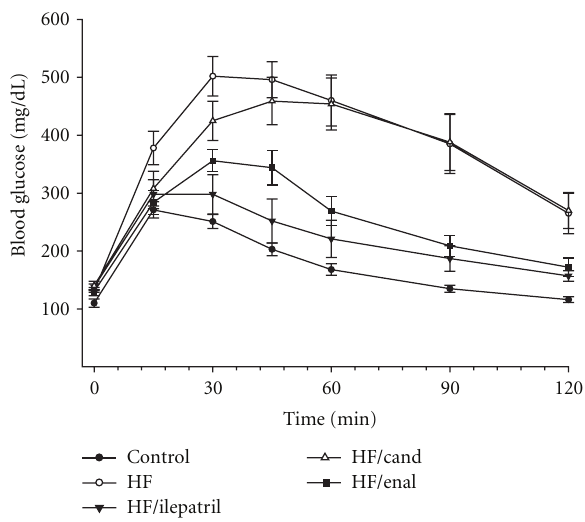
Figure 4: Plasma glucose concentration curve during intraperi- toneal glucose tolerance test (IPGTT) for NEP − / − mice fed a normal or high-fat-containing diet for 24 weeks and the high-fat diet with or without ilepatril, candoxatril, or enalapril for the last 12 weeks (intervention protocol). Data are the mean ± SEM in mM. Fasting basal blood glucose levels were 110 ± 7, 131 ± 5, 138 ± 5, 140 ± 8, and 130 ± 7mg/dL for control, high fat, high fat + ilepatril, high fat + candoxatril, and high fat + enalapril, respectively. Control (closed circles), high fat (open circles), high fat + ilepatril (closed innervated triangle), high fat + candoxatril (open triangle), and high fat + enalapril (closed rectangle). The area under the curve (AUC) was significantly di ff erent P < 0 . 01 for high-fat-fed mice versus control and high fat-fed-mice treated with candoxatril versus control. There was no significant di ff erence for AUC between mice fed a high fat-diet containing ilepatril or enalapril versus control. The number of mice in each group was the same as shown in Table